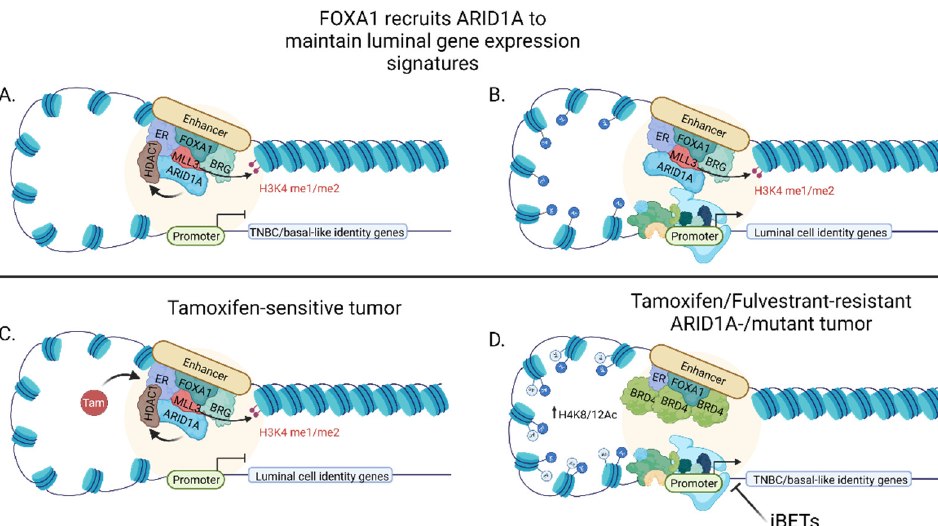
Figure 1. FOXA1 dictates luminal cell identity and response to endocrine-directed therapies in breast cancer. ( A ) FOXA1 represses expression of TNBC/basal-like signature genes and ( B ) facilitates luminal gene expression through recruitment of ER, transcription factors, and the SWI/SNF complex member, ARID1A; ( C ) FOXA1 and ARID1A are critical for endocrine-directed therapeutic response in breast cancer; ( D ) Therapy resistance driven by ARID1A mutation or loss is associated with acquisition of BRD4 binding and sensitivity to BET inhibition in breast cancer. Created with BioRender to represent findings published by [45,58–62].